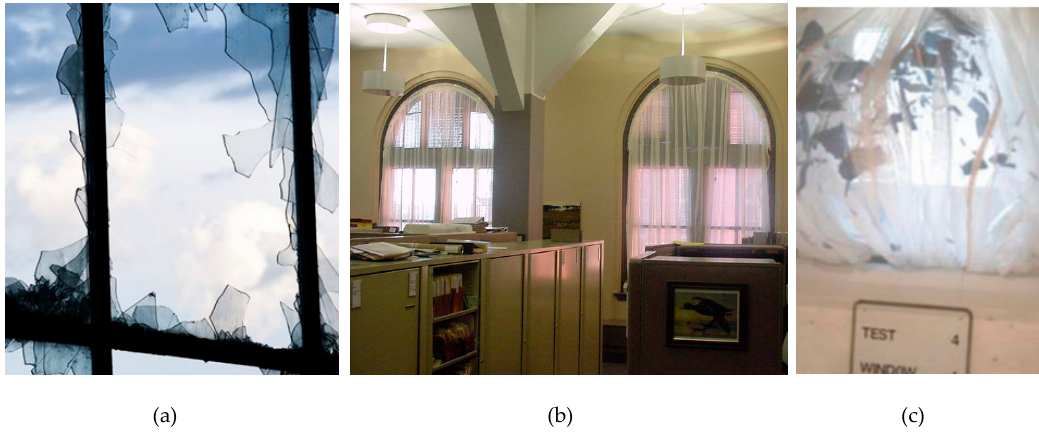
Figure 14. Glass windows and facades under shock: ( a ) example of severe damage of un-protected window and ( b )-( c ) enhanced performance in presence of textile curtain nets.